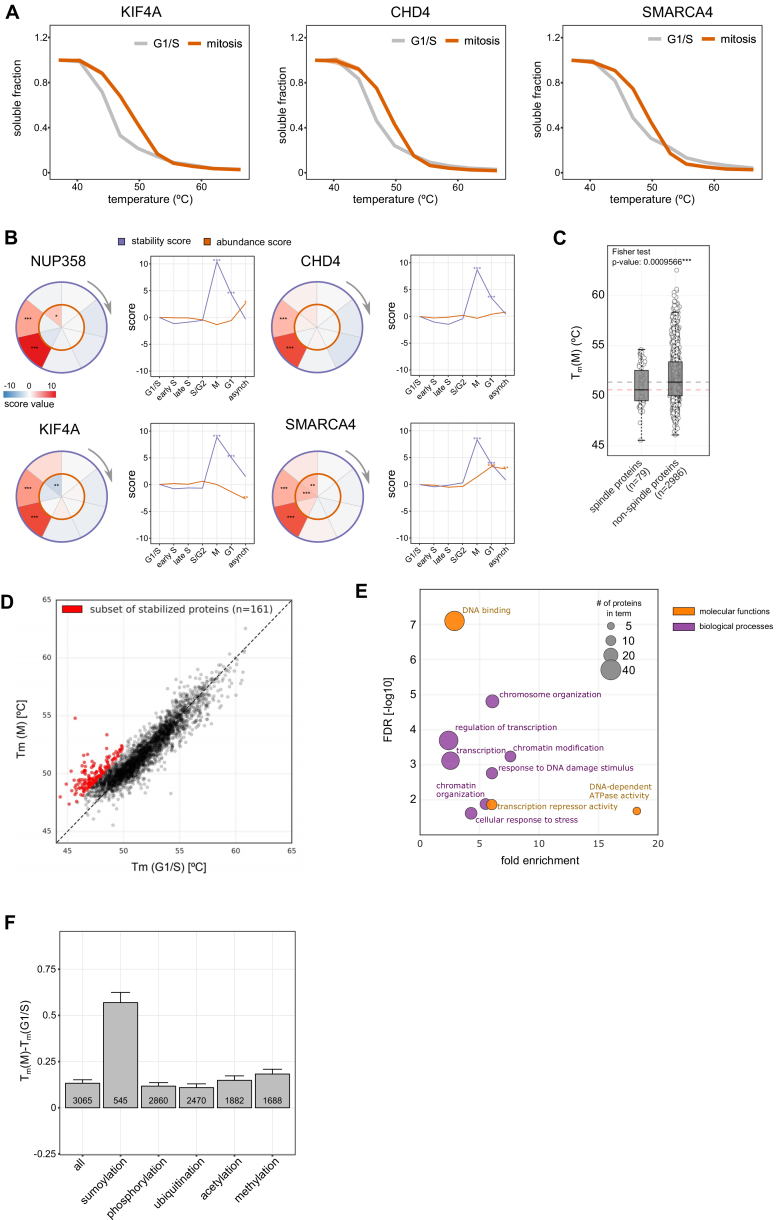
Related to Figure 6(A) Melting curves for CHD4, KIF4A and SMARCA4A. Data shows the median for three replicates.(B) Circle and line plots showing abundance (NP-40, orange) and stability scores (purple) for NUP358, CHD4, KIF4A and SMARAC4.(C) Boxplot comparing melting temperatures in M, on the left are annotated spindle proteins from Sauer et al. The horizontal lines show the median of non-spindle proteins (black line) and spindle proteins (red line) indicating the lower melting temperatures of spindle proteins.(D) Melting temperatures for G1/S and M. Proteins in red were selected for further GO analysis shown in (E).(E) GO for spindle proteins shown in (D). GO analysis using DAVID (https://david-d.ncifcrf.gov/) was conducted on the protein set that is stabilized in mitosis relative to the G1/S reference point. For filtering we considered proteins that were significantly stabilized (p value < 0.1) and with their melting point in mitosis below 55°C and in G1/S below 50°C. The resulting 161 proteins were primarily found to be involved in DNA-binding activity and chromatin-associated processes. The scatter illustrates the fold-enrichment against the respective FDR for terms derived from the broad categories “molecular function” and “biological processes.” The size of each bubble relates to the number of proteins identified for each term.(F) Difference in melting points (G1/S versus M) of all proteins, and proteins annotated with different post-translational modifications (specified in the STAR Methods). SEM is shown.